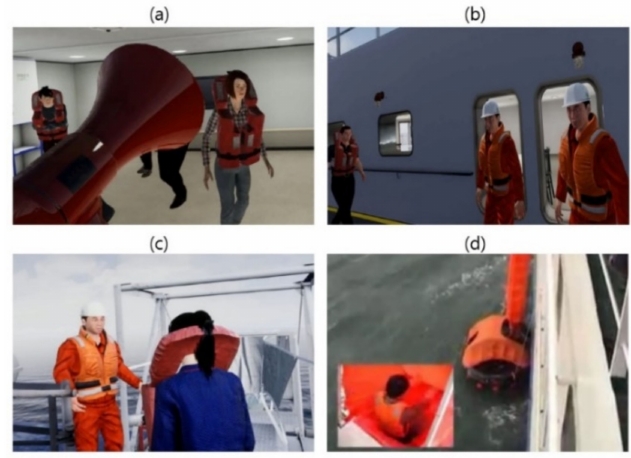
Figure 2. Video contents: ( a ) alarm sound, ( b ) escape from cabin to muster station, ( c ) evacuation station, ( d ) evacuation status.